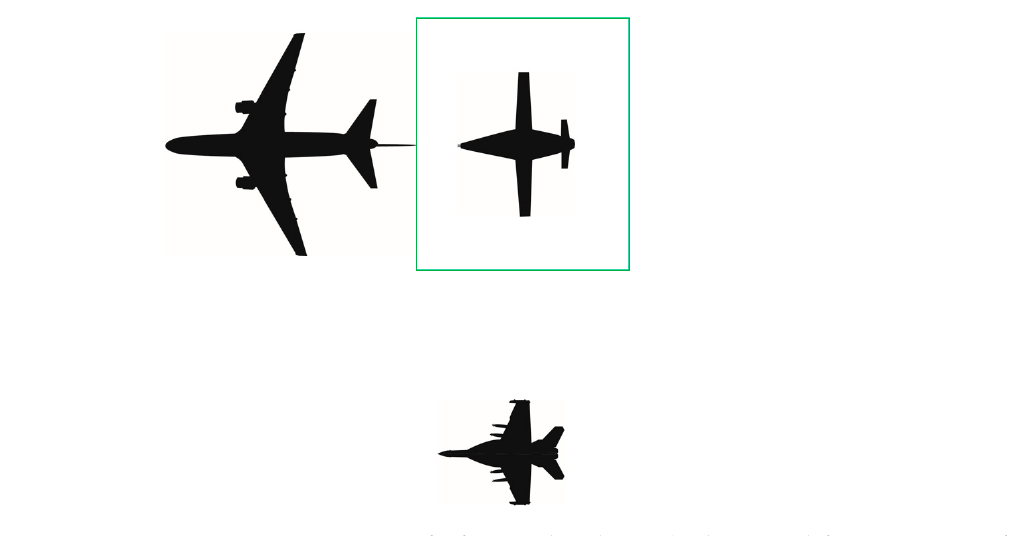
Figure 4. Astern position aft of a centerline drogue (tanker at top left; receiving aircraft at top right). Relative to the position of the tanker aircraft’s fuselage or wing, the drogue will nom ‐ inally flow in the airstream 50 to 90 feet aft of the tanking platform (Figure 5) [18]. There ‐ tanker aircraft for the receiver aircraft to prepare for refueling.